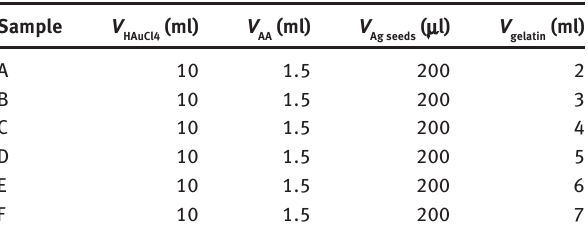
Table 1: Synthesis specifications of star-shaped Ag@Au NPs.